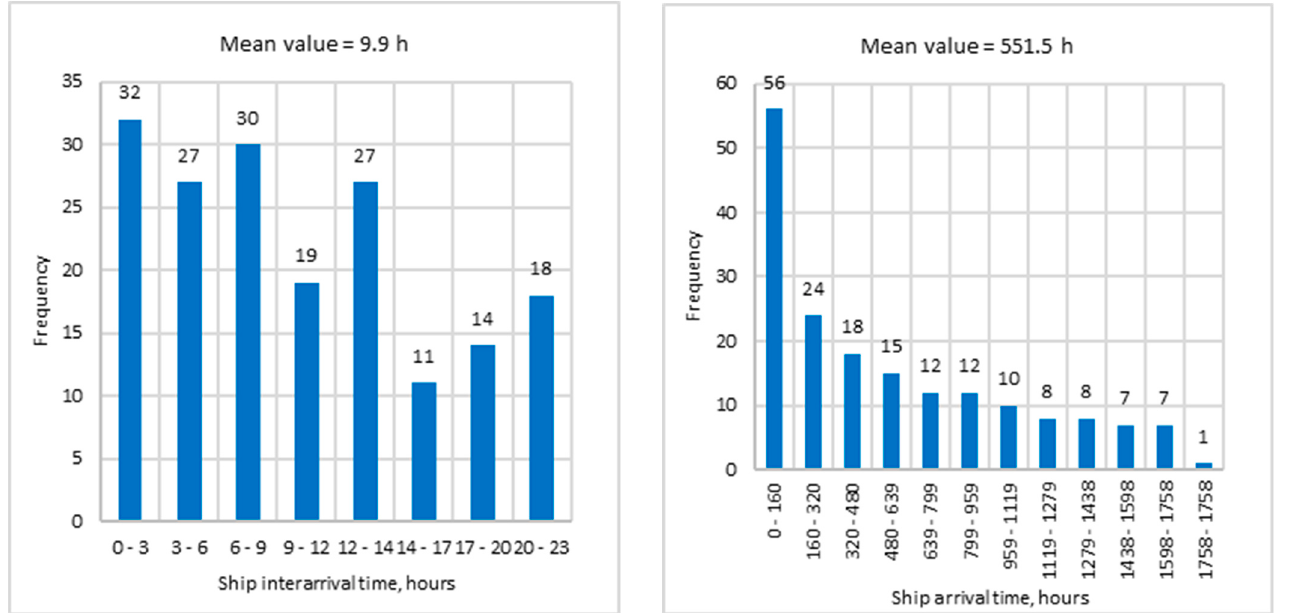
Figure 4. Ship interarrival ( left ) and arriving ( right ) time.